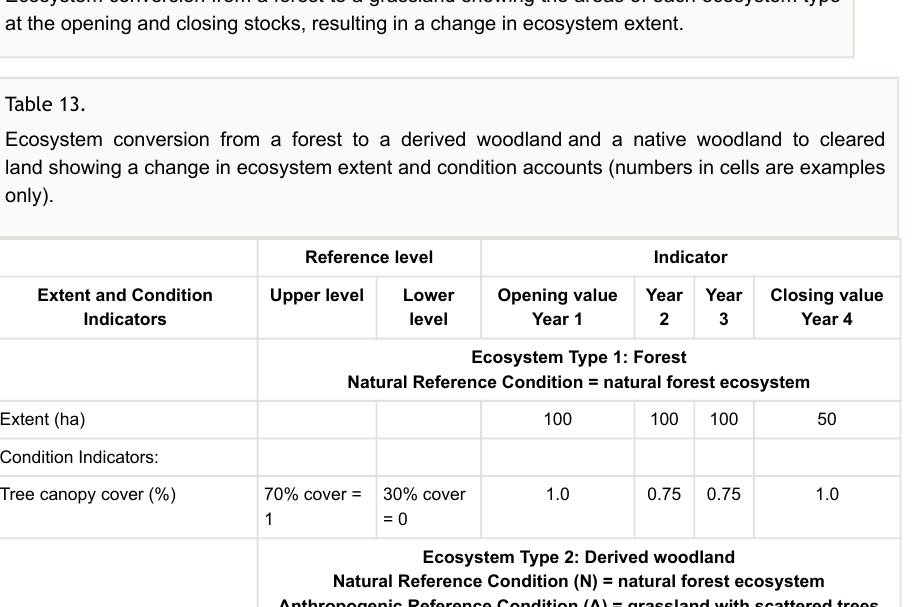
Anthropogenic Reference Condition (A) = grassland with scattered trees